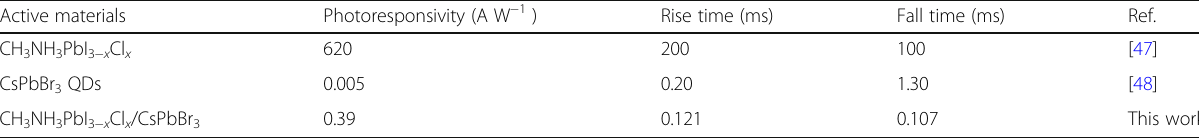
Table 1 Comparison of the device performances of CH 3 NH 3 PbI 3 − x Cl x /CsPbBr 3 device with its single counterparts